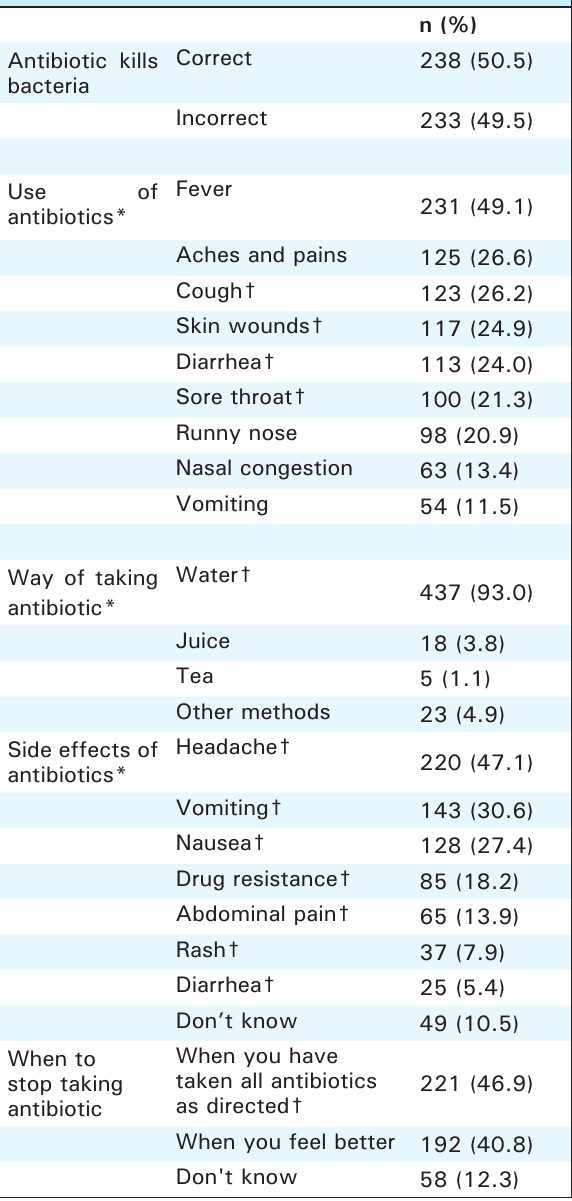
Table 1. Knowledge regarding